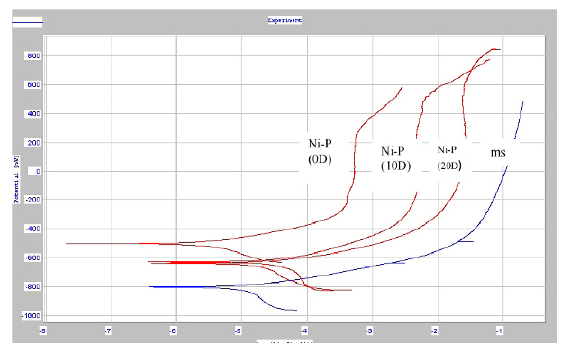
Figure 6. Anodic Polarization for mild steel (ms) and Ni-P coating after different exposure times in 3.5% solution of NaCl: zero days (0D), ten days (10D), and twenty days(20D).